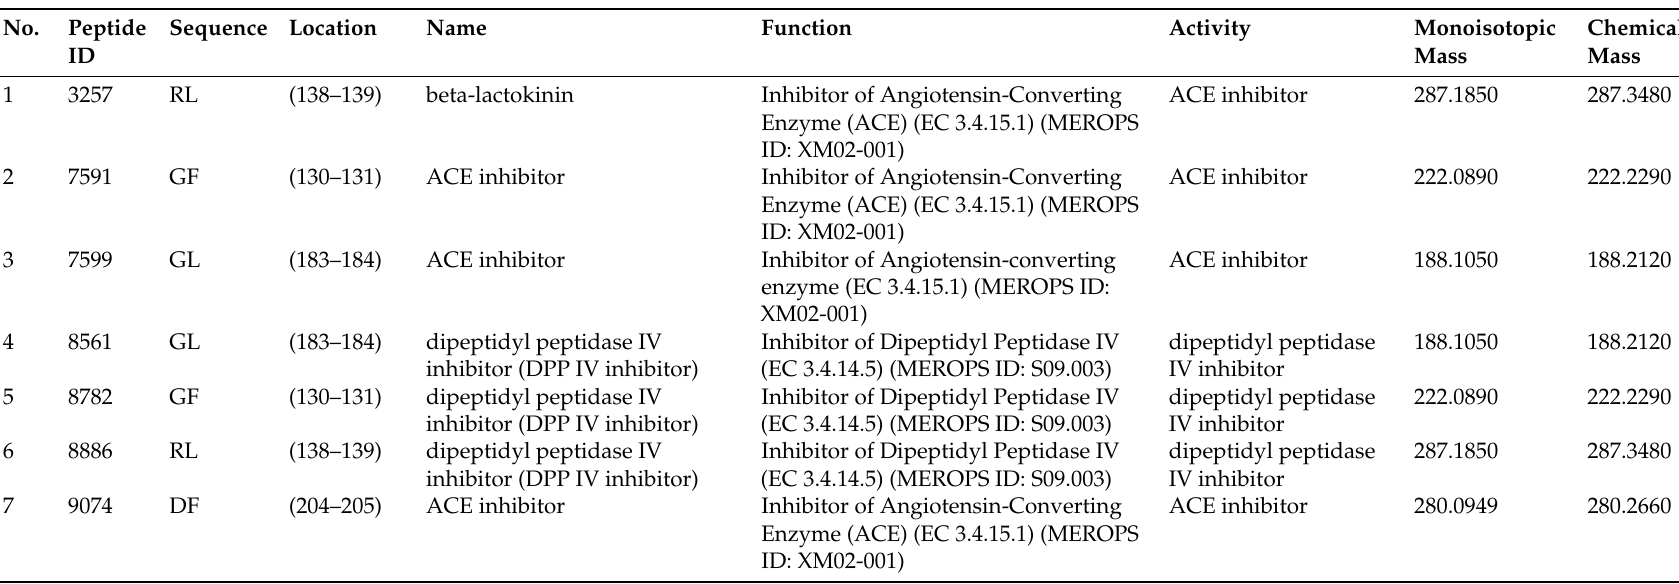
Table A45. Bioactive peptides from RubisCO of Halophila stipulacea . In silico enzymatic cleavage was carried out by using oligopeptidase F.